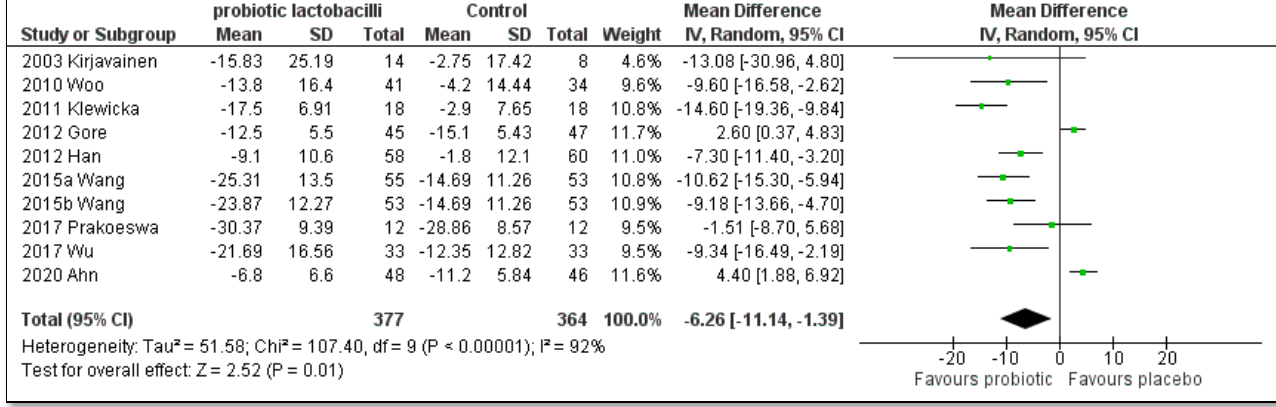
Figure 5. Subgroup meta-analyses of the effect of 12 weeks treatment time with single-strain probiotic